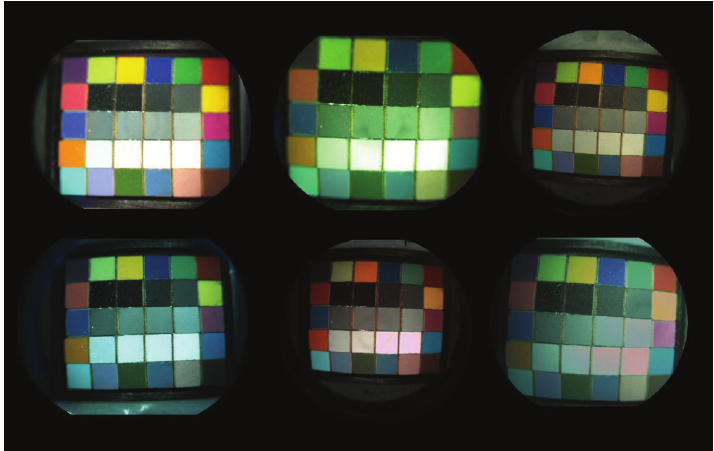
Figure 2: Six of the tested cameras test target